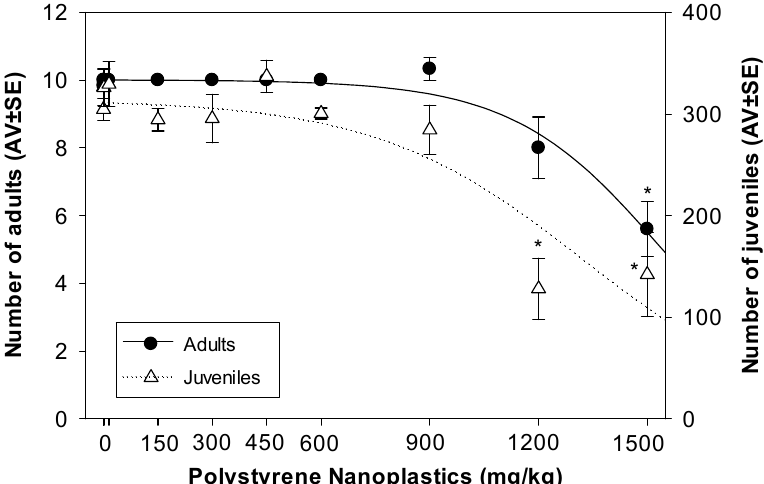
Figure1. UV–Vis( a )andFouriertransforminfraredspectroscopy( b )spectraofpolystyrenenanoplasticsdispersion. Figure 1. UV–Vis ( a ) and Fourier transform infrared spectroscopy ( b ) spectra of polystyrene nanoplastics dispersion.